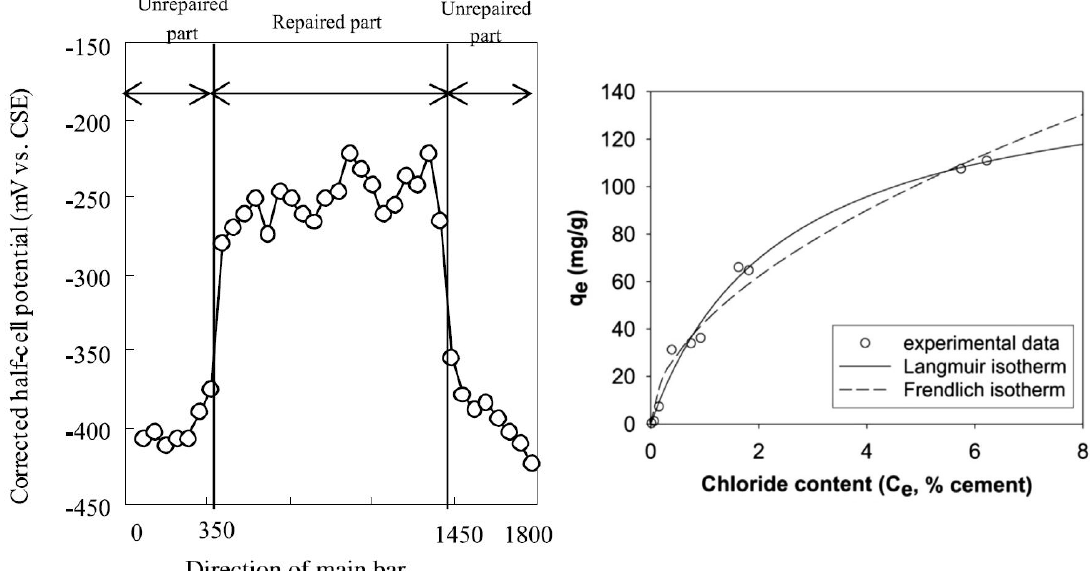
Figure 7. ( Left ) Figure shows steel with protective potential in the repaired part containing LDH with corrosion inhibitor (reprinted from [133] with permission from Elsevier). ( Right ) Experimental and fitted isotherms, both Langmuir and Freundlich for chloride uptake by LDH in cement paste (reprinted from [82] with permission from